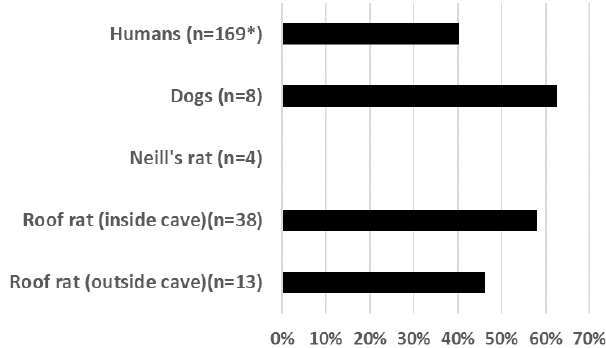
Figure 3. Summary of antibody prevalence for KKV among humans, rats, and dogs around Kaeng Khoi cave. * Human seroprevalence reported here represents an average of the data presented in Table 1.